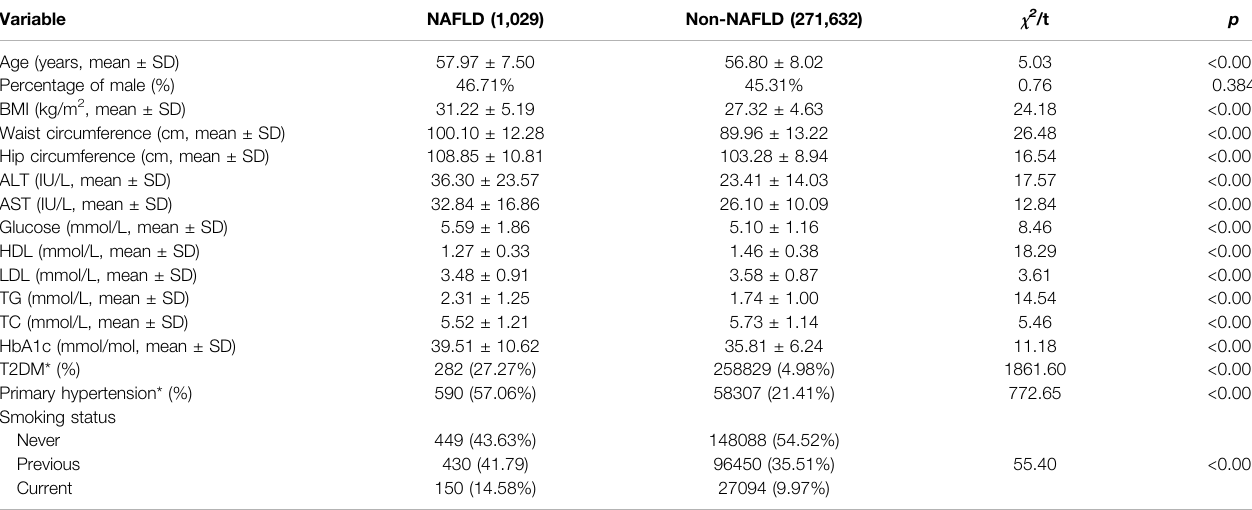
TABLE 1 | Baseline characteristics of the study